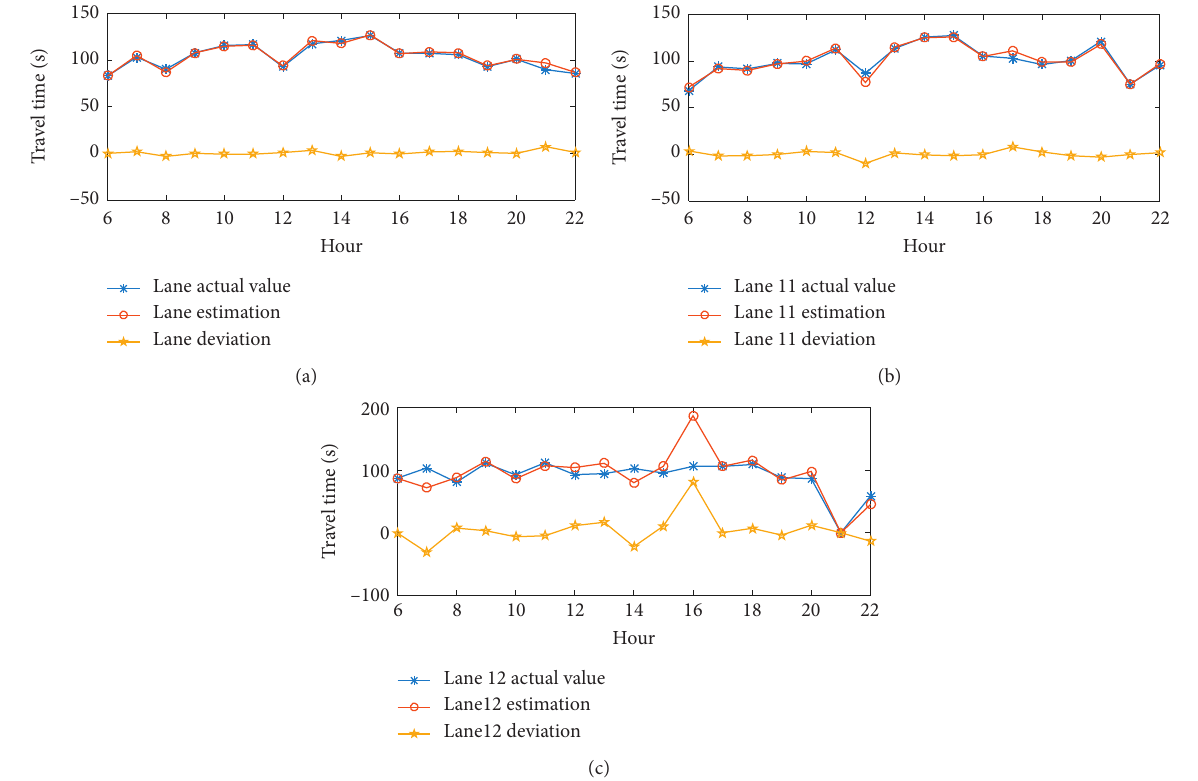
Figure 12: Lane travel time estimated based on typical vehicle average travel time on December 2, 2015.